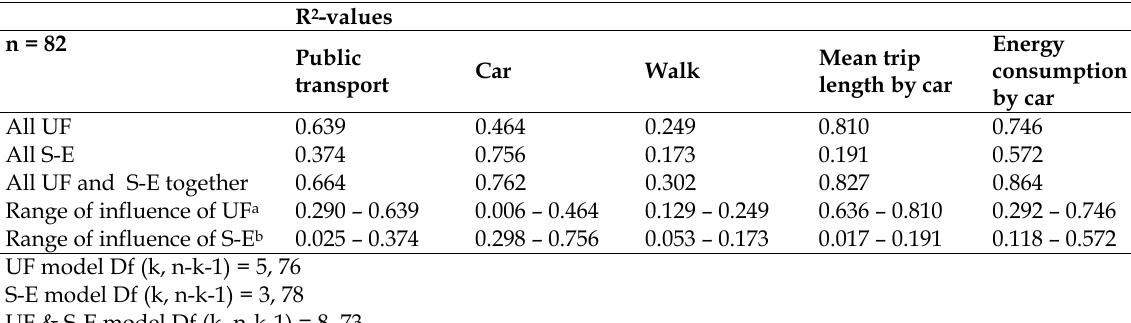
Table 5. Results of multiple regression analyses performed, comparing the influence of UF and S-E on five travel